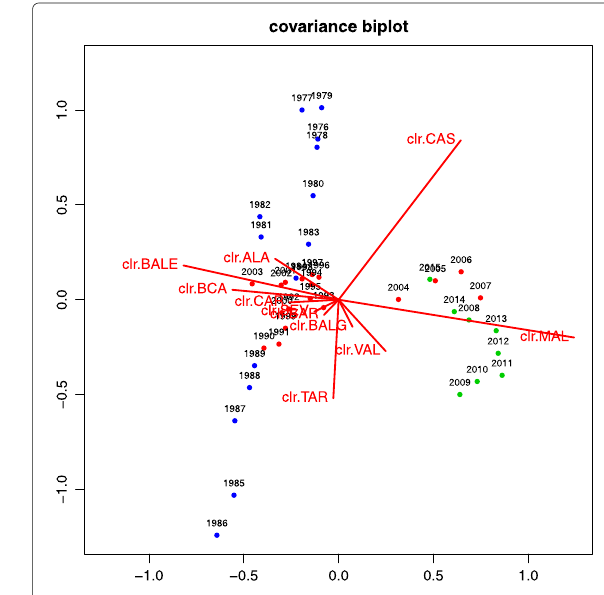
Fig. 8 Covariance Biplot. SpanishMed traffic composition. The projection represents more than 68% of variance. Blue dots correspond to the period 1976–1989 (before containerization boom), red dots correspond to the period 1990–2007 (before the crisis) and green dots correspond to the period